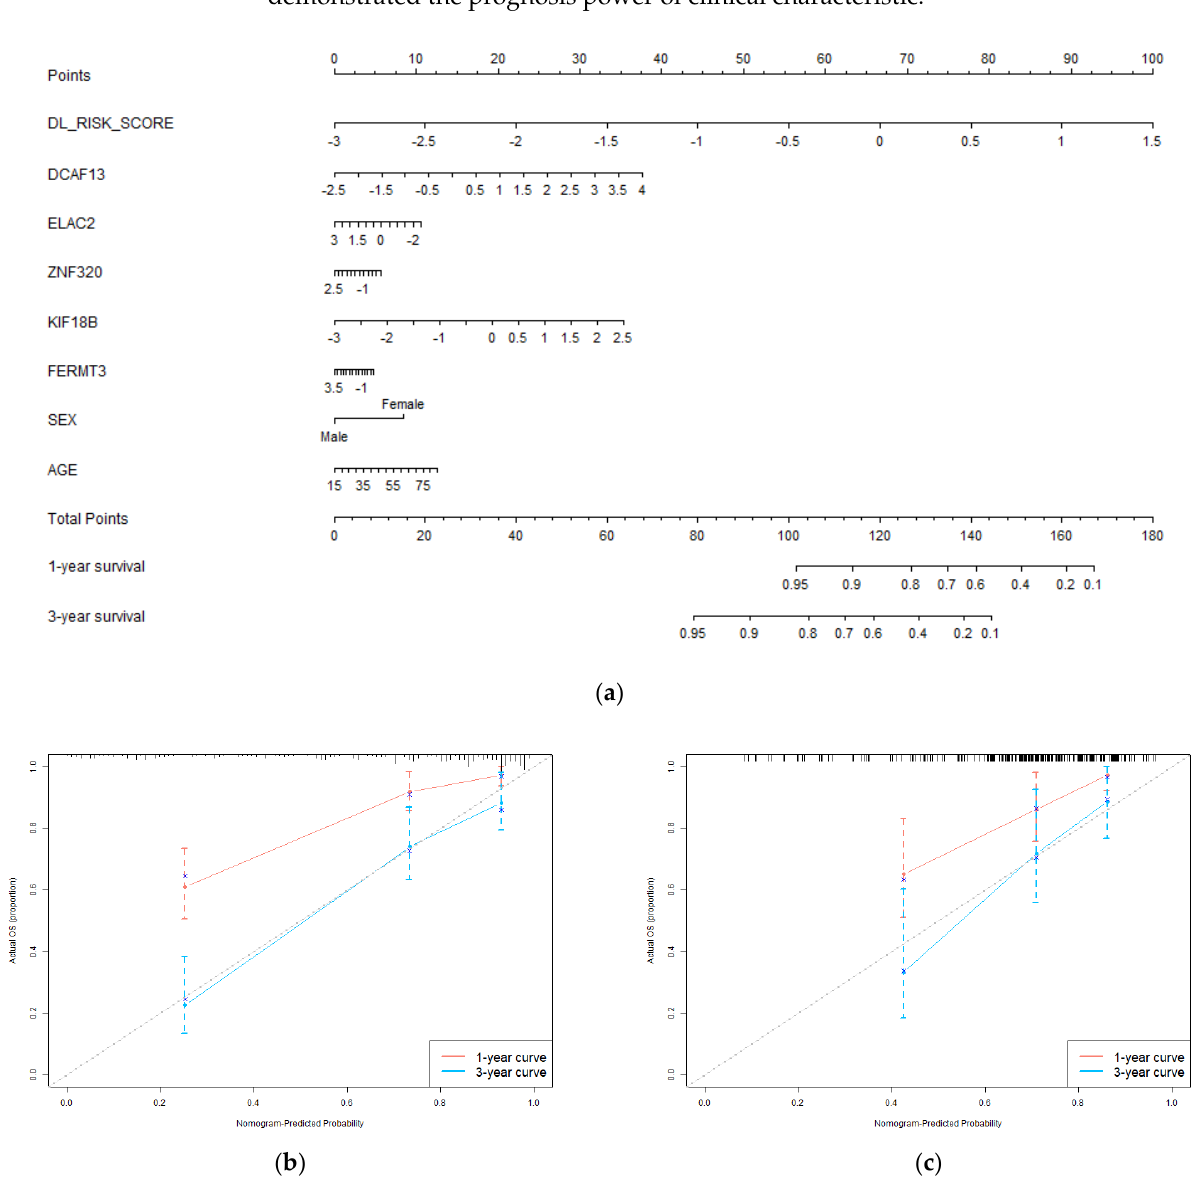
Figure 5. Evaluation of the predictive performance of the integrated prognostic model. ( a ) The nomogram incorporates deep learning pathology risk score, genomic module hub genes, and clinical characteristics of the patients in the training set; ( b ) The calibration curve of the nomogram for 1 − year and 3 − year overall survival prediction in the training set; ( c ) the calibration curve of the nomogram for 1 − year and 3 − year overall survival prediction in the test set.